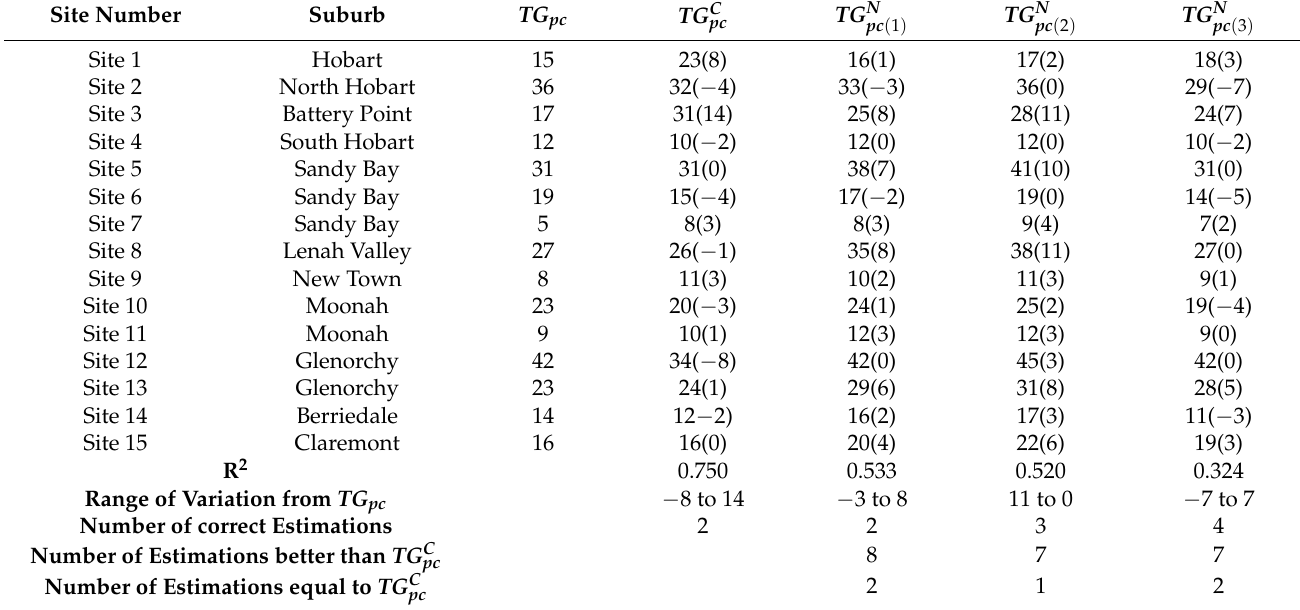
Table 4. Private car trip generation estimation based on the number of children at the